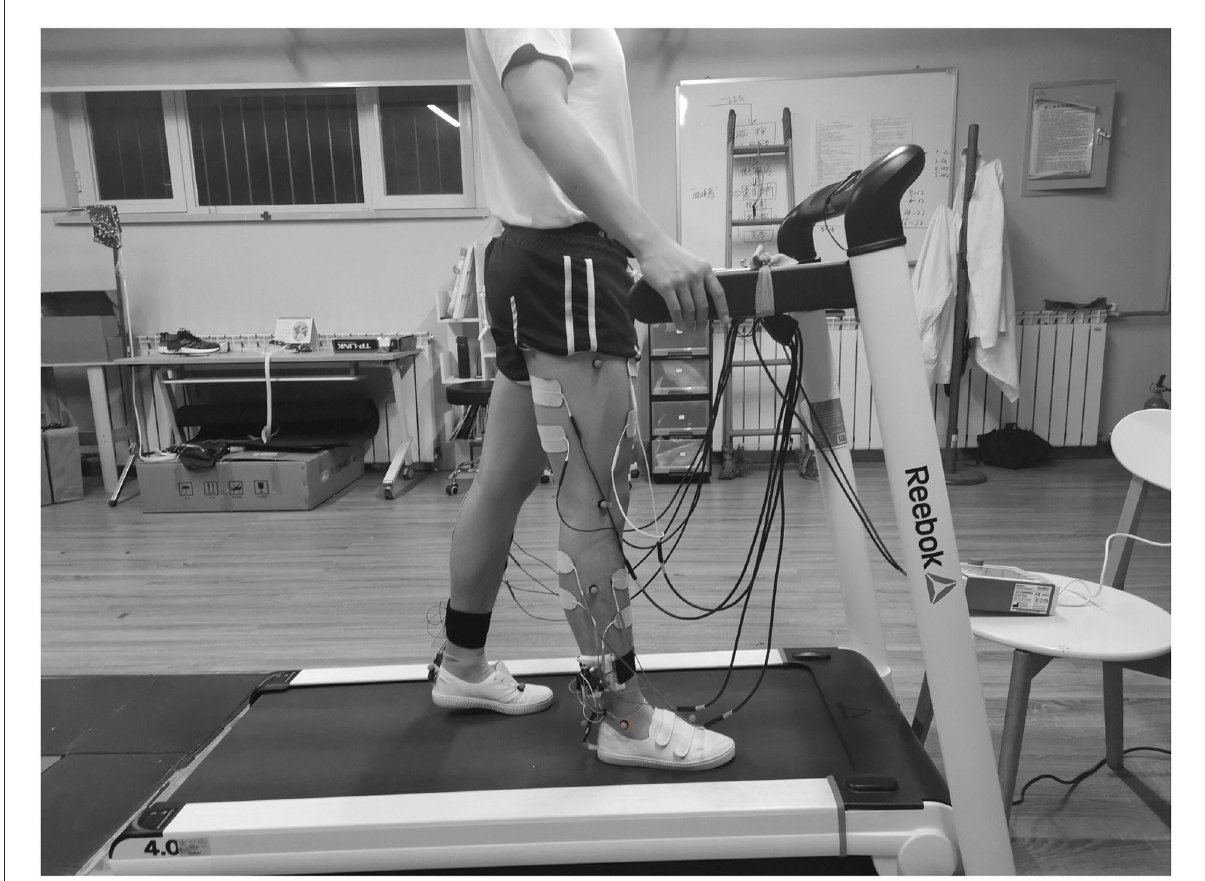
FIGURE5 Schematic of the experimental setup: a participant walked on the treadmill wearing real-time gait detection devices. Electrical stimulation electrodes were attached to the eight muscles, and the retroreflective markers were placed on the lower limbs.